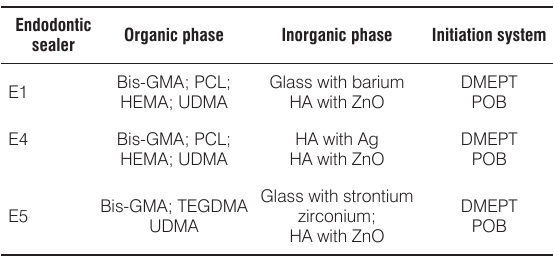
Table 1. The composition of the endodontic materials employed in the present